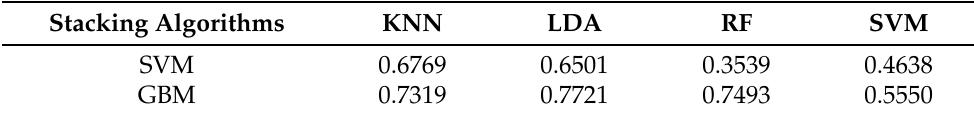
Table 3. Accuracy values of stacking algorithms for the living room gateway.